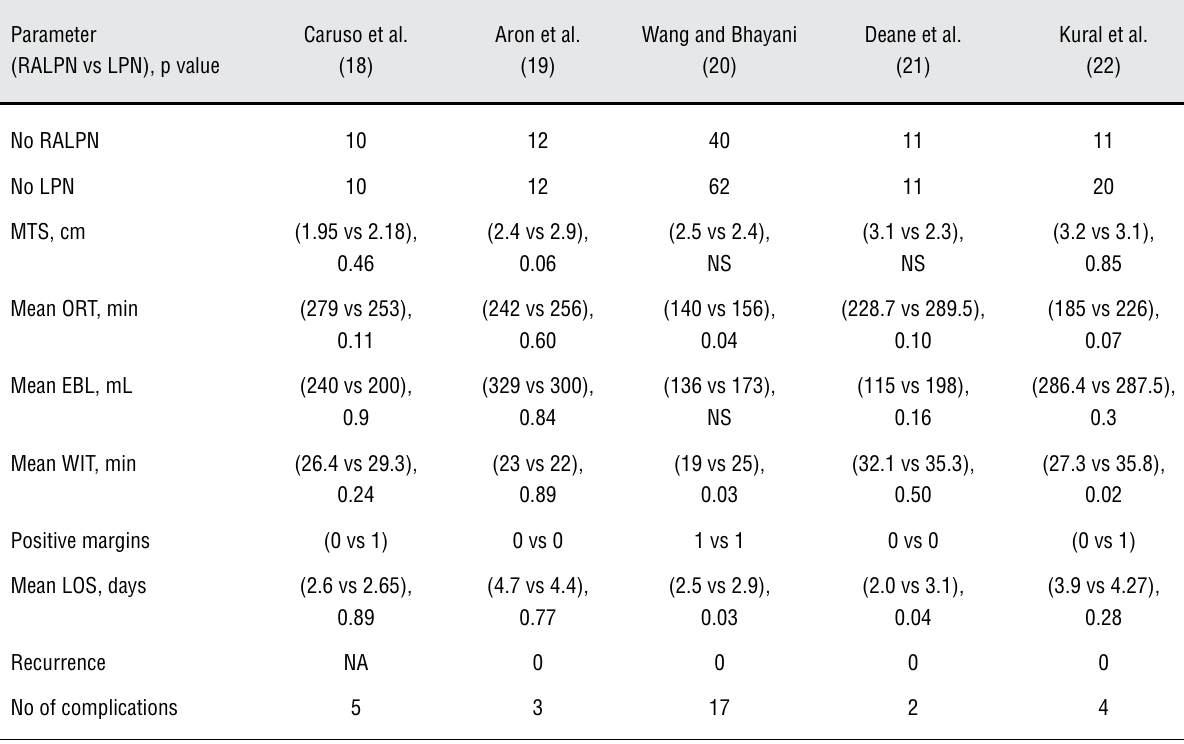
Table 6 - Robotic versus Laparoscopic Partial Nephrectomy.